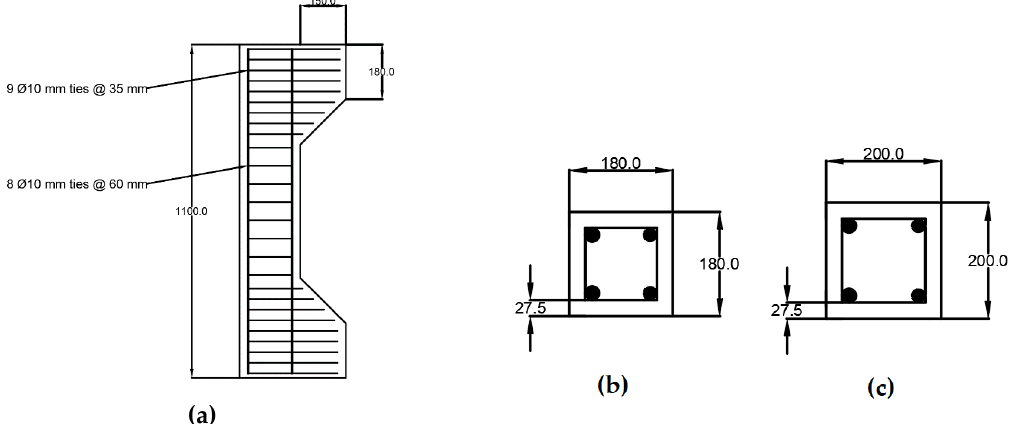
Figure 10. Rectangular FRP-RC column details: ( a ) column dimension; ( b ) cross section of the 180 mm × 180 mm column; ( c ) cross section of the 200 mm × 200 mm column.